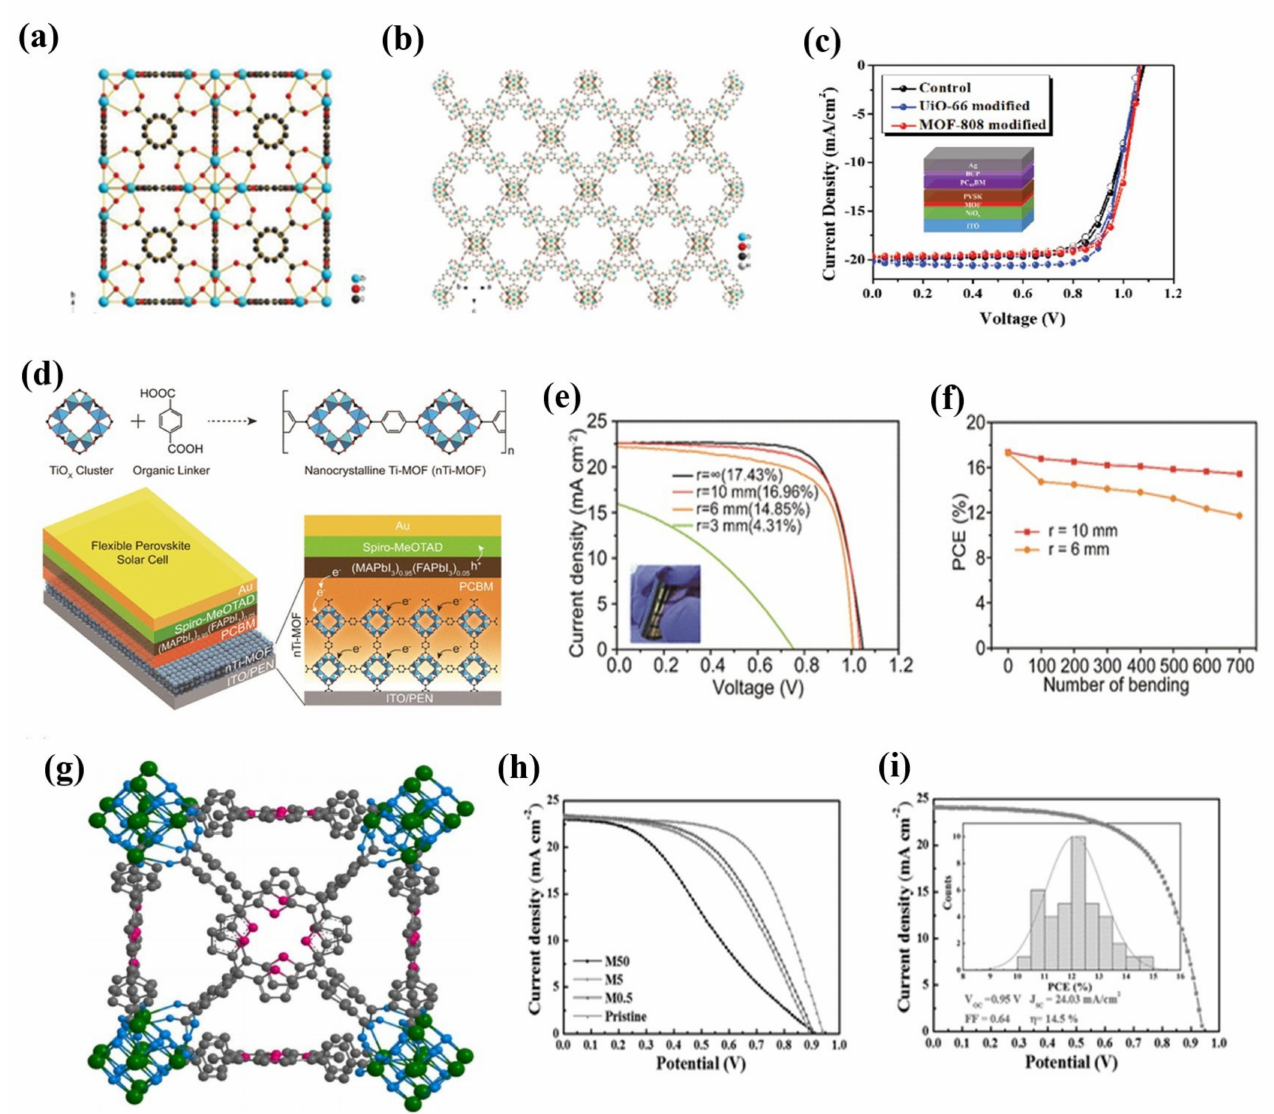
Figure 4. ( a ) The crystal structures of UiO-66 and ( b ) MOF-808 are illustrated. ( c ) The J-V curves of the MOF-modified devices measured under 1 sun. Adapted with permission from [114] under Creative Commons CC BY License. ( d ) Schematic of the synthesis protocol for nanocrystalline Ti-MOF (nTi-MOF). The successively linked TiO 2 clusters with BDC molecules create small nanocrystals. The device structure of a flexible perovskite solar cell incorporating nTi-MOF/PCBM ETL. The magnified image indicates electron and hole transfer from the perovskite toward interlayers, nTi-MOF/PCBM and spiro-MeOTAD, respectively. ( e ) J-V curves of the flexible devices measured from r = ∞ to r = 3 mm and ( f ) bending test of the devices for r = 10 mm and r = 6 mm up to 700 bending cycles. Adapted with permission from [113]. Copyright 2018, American Chemical Society. ( g ) Crystal structure of MOF-525. Is illustrated ( h ) J-V curves of the perovskite and MOF/perovskite solar cells and ( i ) J-V curve of the best M5 cell. Inset: histogram of average PCE values of 40 devices. Adapted with permission from [111]. Copyright 2015, WILEY-VCH Verlag GmbH & Co. KGaA,